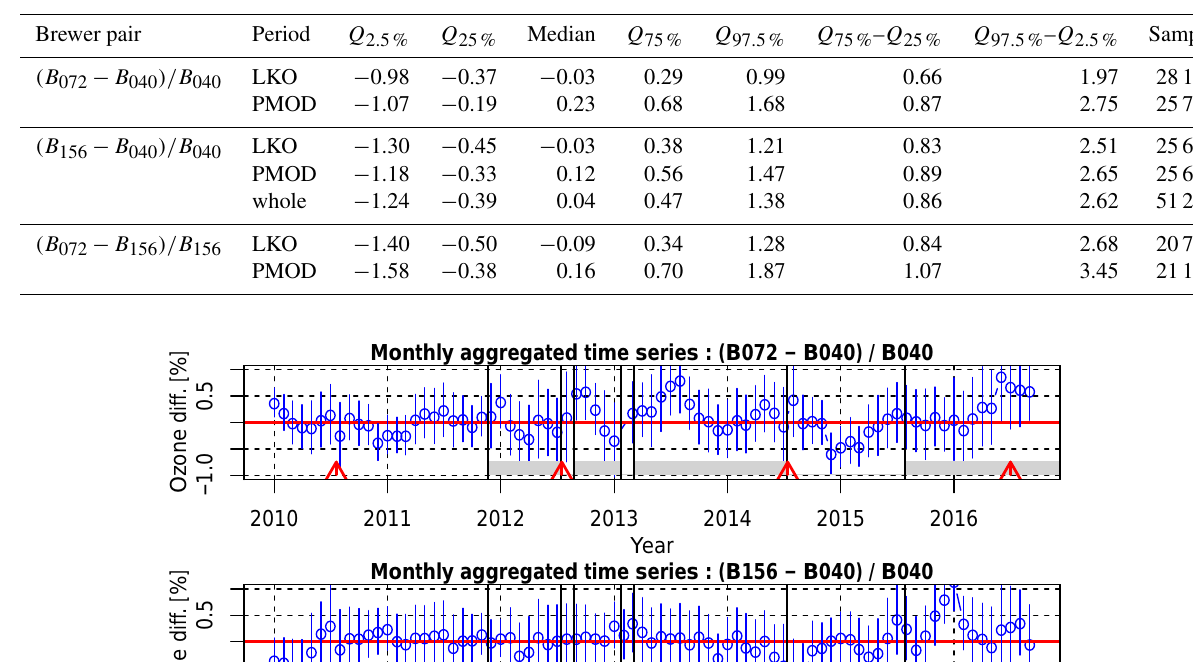
an offset δ B and a SD σ B calculated as: nnn nnn